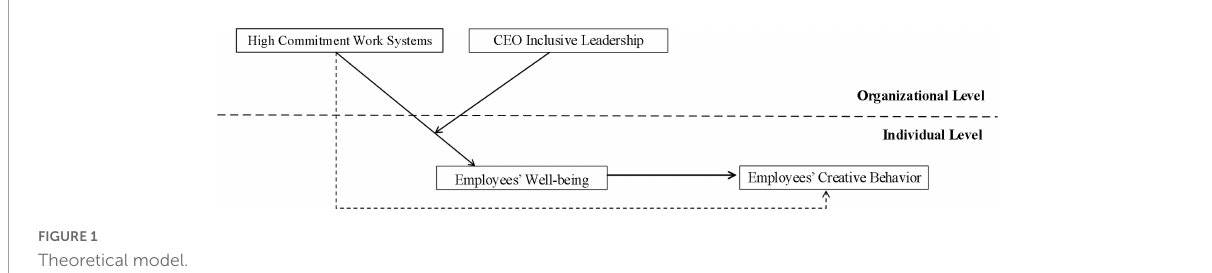
FIGURE1 Theoretical